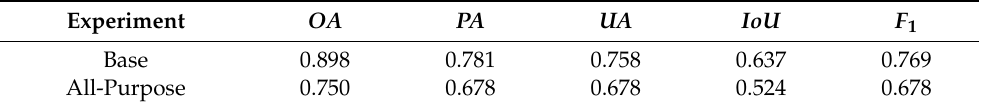
Table 8. Global metrics for the experiment with DeepLabV3+ on UOPNOA.